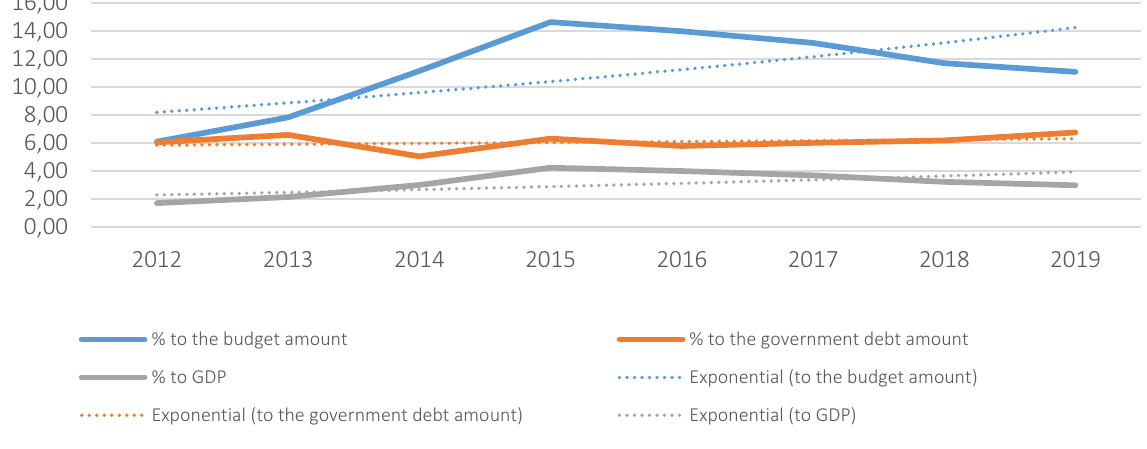
Figure 3. Dynamics of debt service